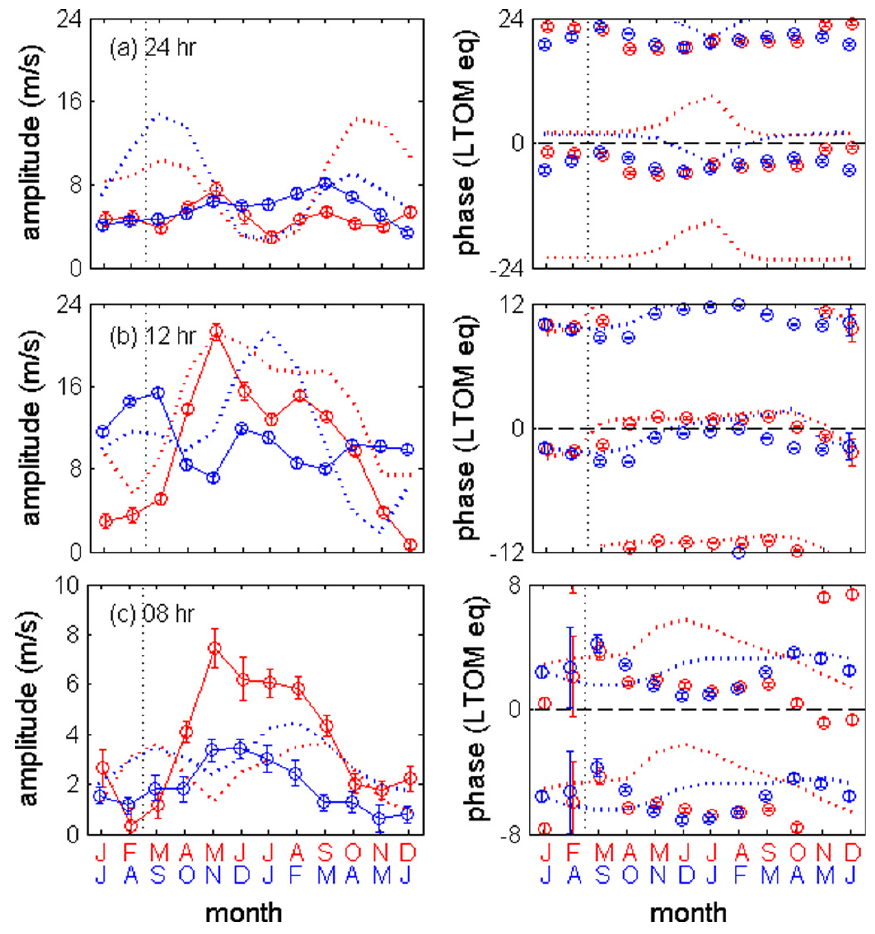
Fig. 9. Monthly mean amplitude and phase of the meridional component of the 24-h (a) , 12-h (b) , and 8-h (c) waves for the Falkland Islands radar (red) and the Goose Bay radar (blue). Goose Bay data have been shifted by six months and the meridional winds reversed so that all phases are presented as the local time of maximum equatorward winds. Error bars represent 95% confidence intervals on the monthly mean fits. The dotted lines represent the equivalent data from the HWM-07 model atmosphere averaged between 85 and 95km